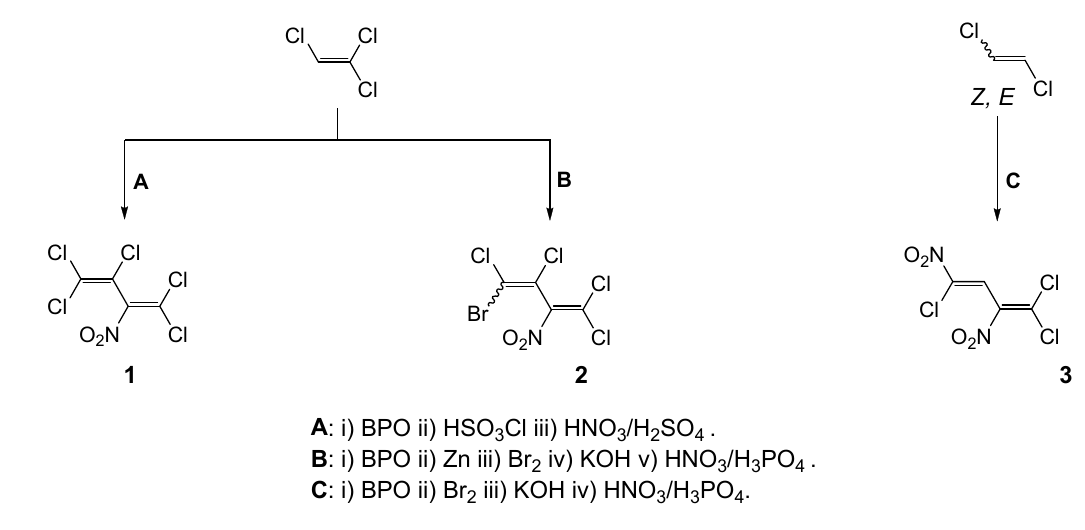
Scheme 1. Synthesis of the polyhalonitrobutadienes 1 – 3 .